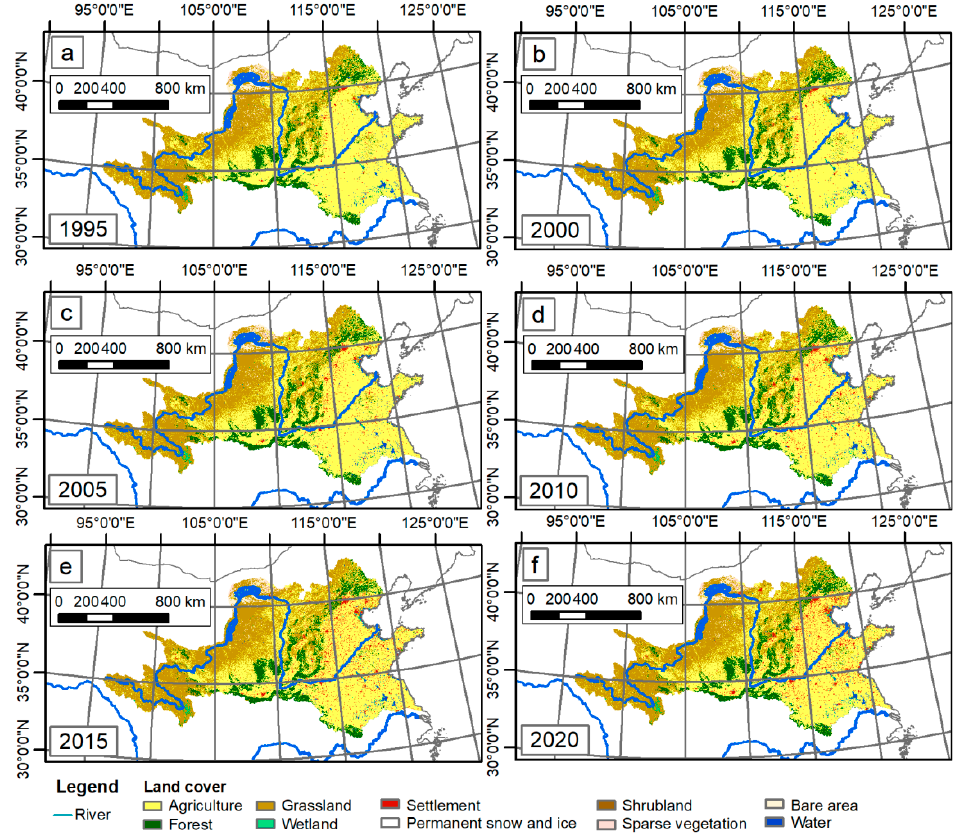
Figure 3. Land cover of the GYRR from 1995 to 2020. ( a ) Land cover in 1995; ( b ) land cover in 2000; ( c ) land cover in 2005; ( d ) land cover in 2010; ( e ) land cover in 2015; ( f ) land cover in 2020. Although the size of the pictures was limited, we could still find the subtle differences between them. For example, the settlement areas displayed in red shows an obvious increasing